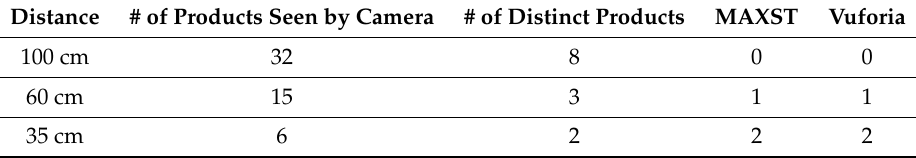
Table 5. The number of cup-type products simultaneously recognized and tracked in the